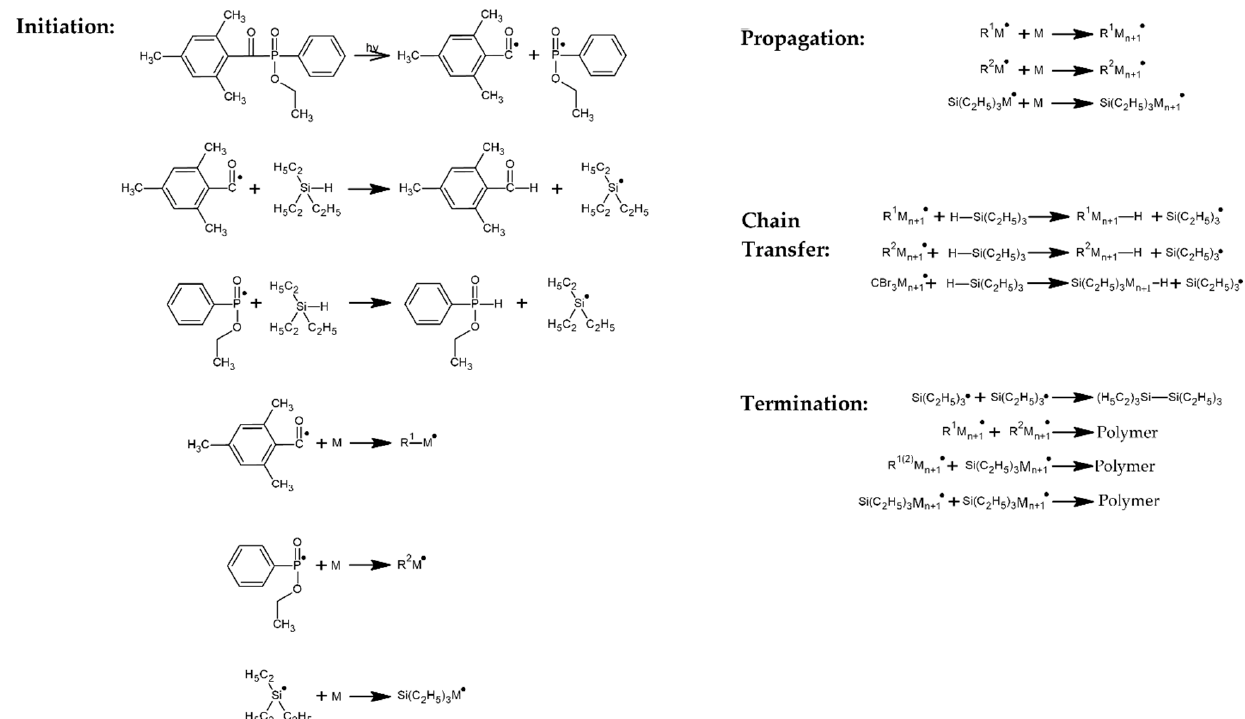
Figure 1. Schematic mechanism of the UV telomerization process (adapted from [17], where M is a taxogen). Table 1. Compositions of the monomers, photoinitiator, and telogen for the preparation of silicone-